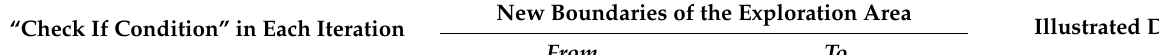
Table 3. The third condition that checked by the ICSA to update the exploration area. “Check If Condition” in Each Iteration New Boundaries of the Exploration Area Illustrated Design From To The right side from the reference power value